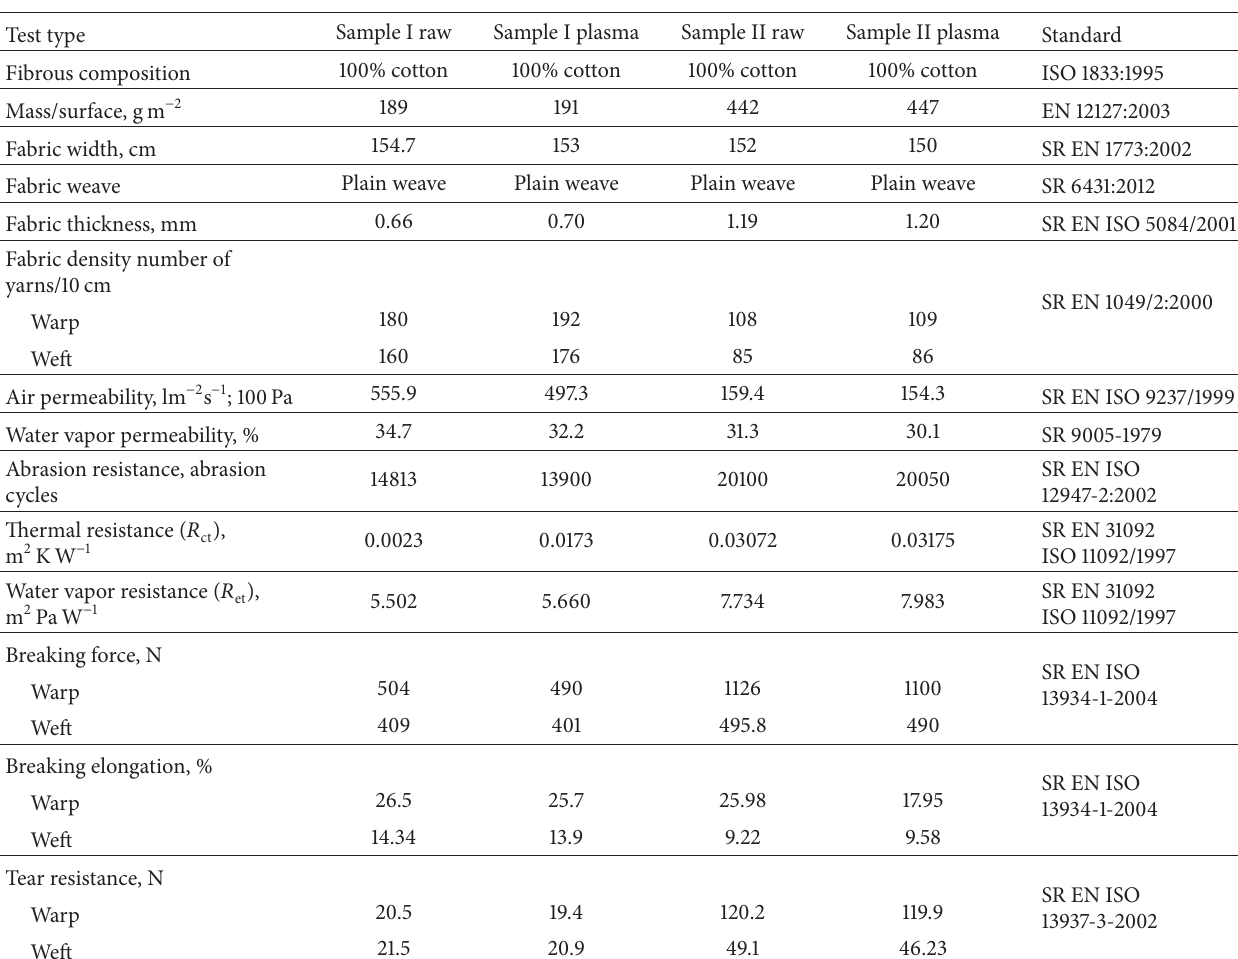
Table 2: Physical-mechanical properties of the